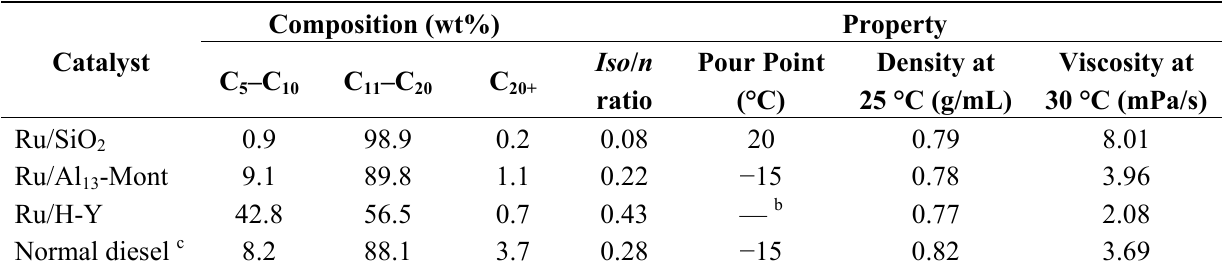
Table 5. Composition and property of the liquid hydrocarbons (C hydrotreatment of waste cooking oil over various catalysts a